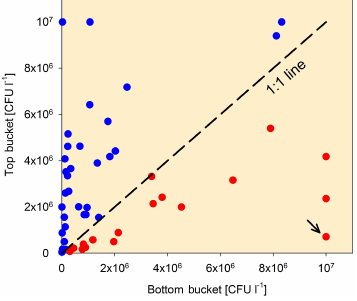
Figure 6. Coliform counts (CFUL − 1 ) in 51 CCFS systems sam- pled by dip slides in Hobeni village; red dots: water quality deteri- oration; arrow: outlier removed for further